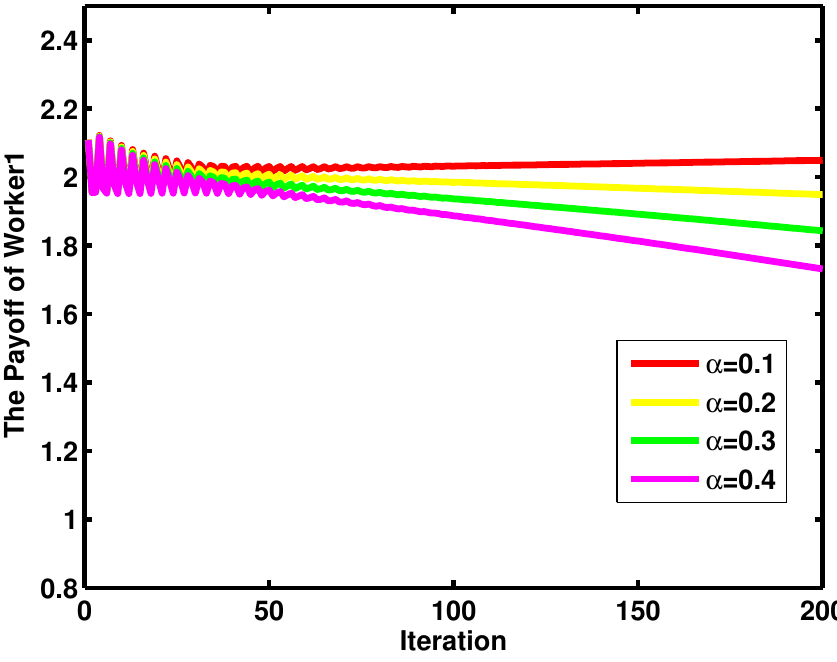
Figure 5. The payoff of worker 1 using ZD2 strategies with different α .